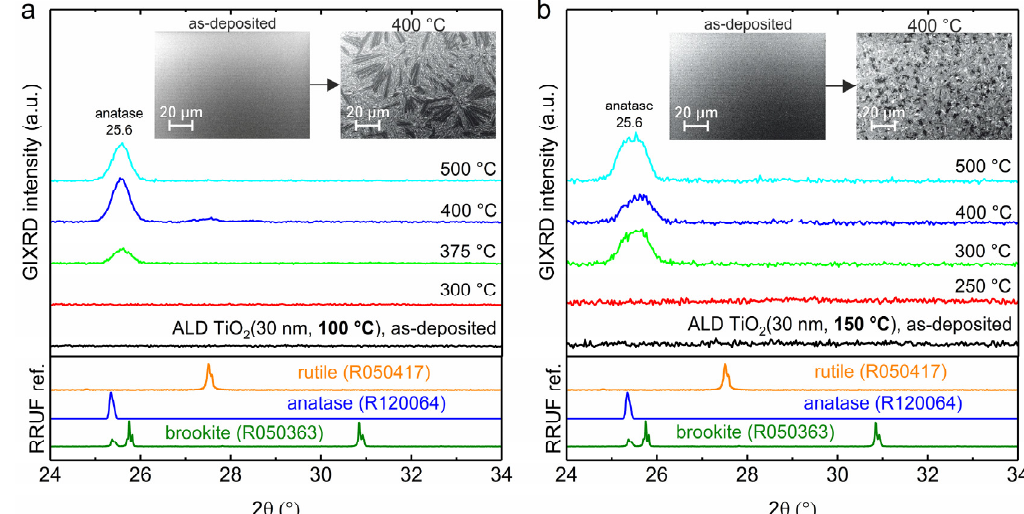
Figure 2. GIXRD patterns for ALD TiO 2 thin films grown at ( a ) 100 °C and ( b ) 150 °C and heat treated in air. The insets show SEM images for the as-deposited and at 400 °C heat-treated samples. XRD reference patterns for rutile, anatase and brookite TiO 2 are from RRUFF database [31].